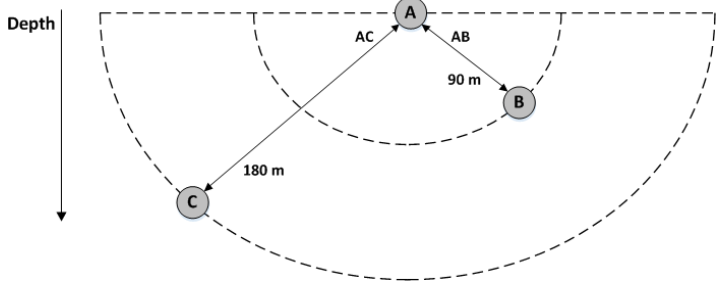
Figure 5. An example of the near and far